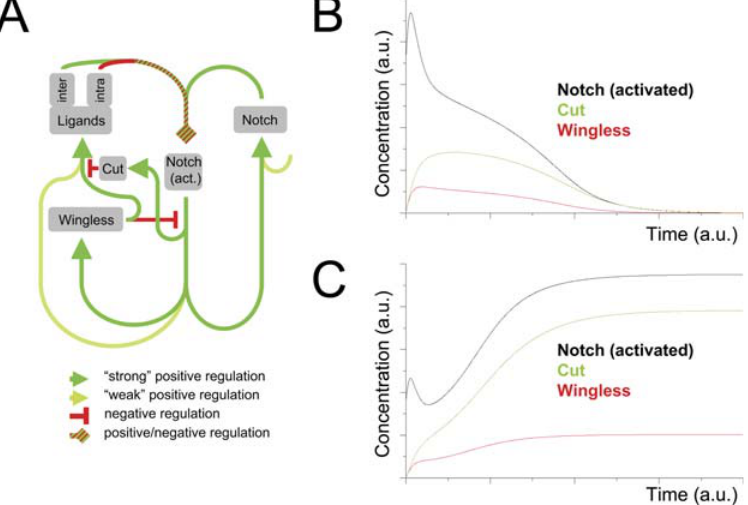
Figure 2. Insilicotesting of the gene regulatory network: refractoriness to Wg in boundary cells renders stability to the DV regulatory network. (A) Regulatory network for the formation of the DV boundary. Positive and negative regulations are coded with green and red colors, respectively. Color intensity in positive regulations indicates, qualitatively, the strength of expression levels (the lighter the weaker). The green-red dashed line that ends with a rhombic arrowhead indicates that receptor-ligand dynamics may lead to either positive or negative regulation: Notch-ligand binding in the same cell (intra) or in adjacent neighboring cells (inter) lead, respectively, to titration (sequestering effects) or activation of Notch. Activated Notch induces ligand and receptor expression at low levels, thus closing a positive feedback loop that maintains each other’s expression at early stages of wing development. Note that Notch has an additional autonomous off-network regulation. Increased Notch activity induces expression of Wg and Cut. The latter represses Ser and Dl. (B) Evolution of Wg (red) expression levels, Notch activated (black), and Cut (green) in boundary cells as a function of time. The boundary is initially established but cannot be maintained (see text). (C) Evolution of Wg (red) expression, Notch activated (black), and Cut (green) levels in boundary cells as a function of time in a scenario in which refractoriness to Wg has been taken into account in boundary cells (see text). Note stable activation of Notch and expression of Wg and Cut in this case, when compared to (B).